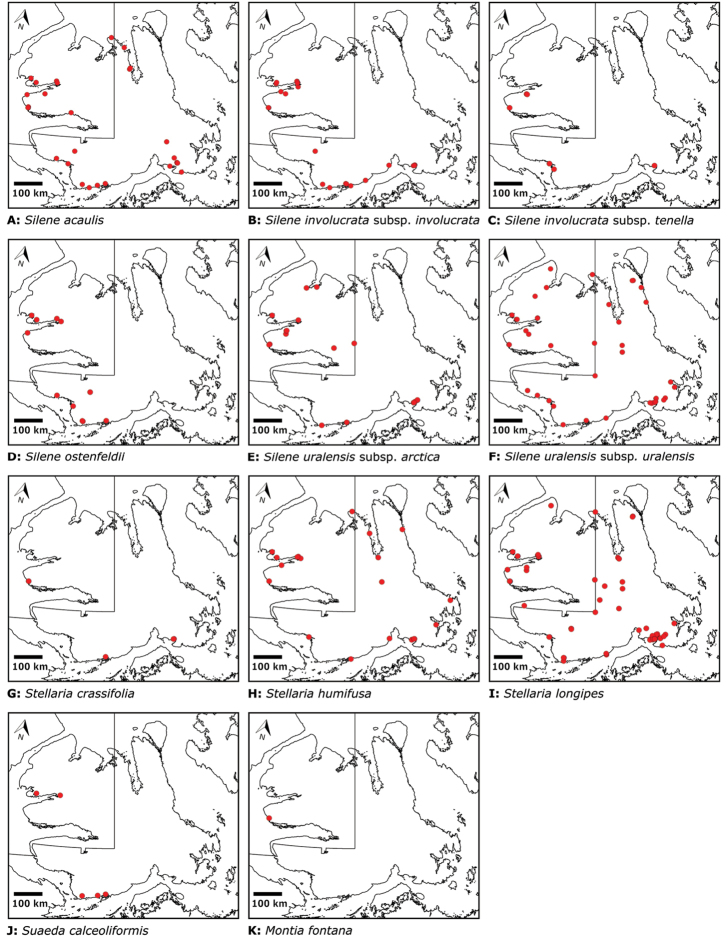
Species distribution maps. Caryophyllaceae: ASilene
acaulisBSilene
involucrata
subsp.
involucrataCSilene
involucrata
subsp.
tenellaDSilene
ostenfeldiiESilene
uralensis
subsp.
arcticaFSilene
uralensis
subsp.
uralensisGStellaria
crassifoliaHStellaria
humifusaIStellaria
longipes. Amaranthaceae: JSuaeda
calceoliformis. Montiaceae: KMontia
fontana.